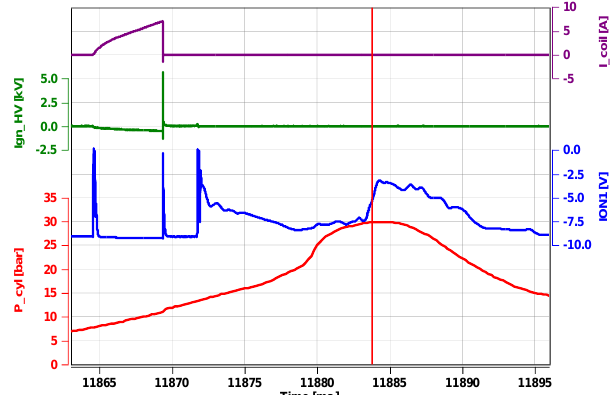
Fig. 4. An example of a pressure signal in a cylinder and electrical wave- forms required for ionization signal analysis The resistance of the spark plug used was 1.6 k  , and the distance between the electrodes d = 0.4 mm. Other RCM operating conditions are presented in Table